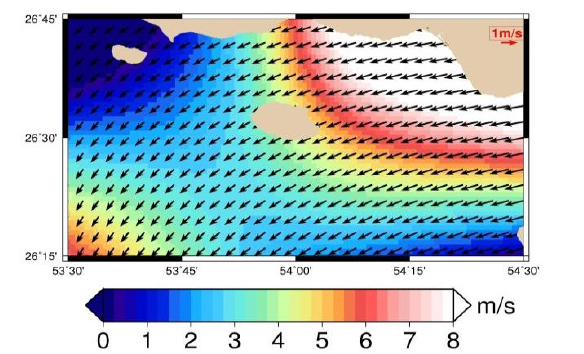
Figure 7. Average of SSW vectors plotted on SSW speed in 27 until 29 Dec 2010 We decomposed sea surface around the Kish Island into 9 zones, e.g., West North (1), North (2), East North (3), West (4), central place (5), East (6), West South (7), South (8) and East South (9). Average of angular differences between FSCs and three data sets are calculated in each zone. These averages are available in table 1-b, c, d. Results of VCE are attainable in table 1-a. Mean angular differences between (OF, GCs and SSW) and FSCs are respectively 55.30º, 70.84º and -30.52º.